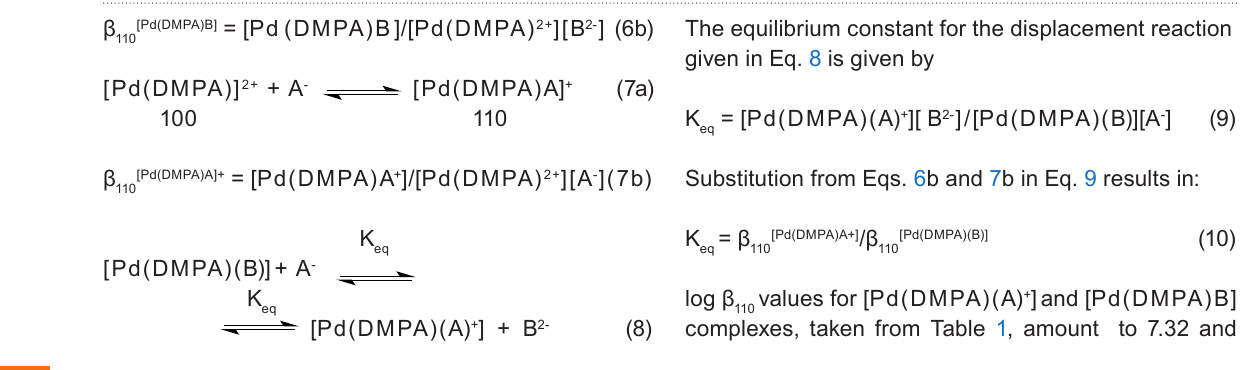
The equilibrium constant for the displacement reaction given in Eq. 8 is given by